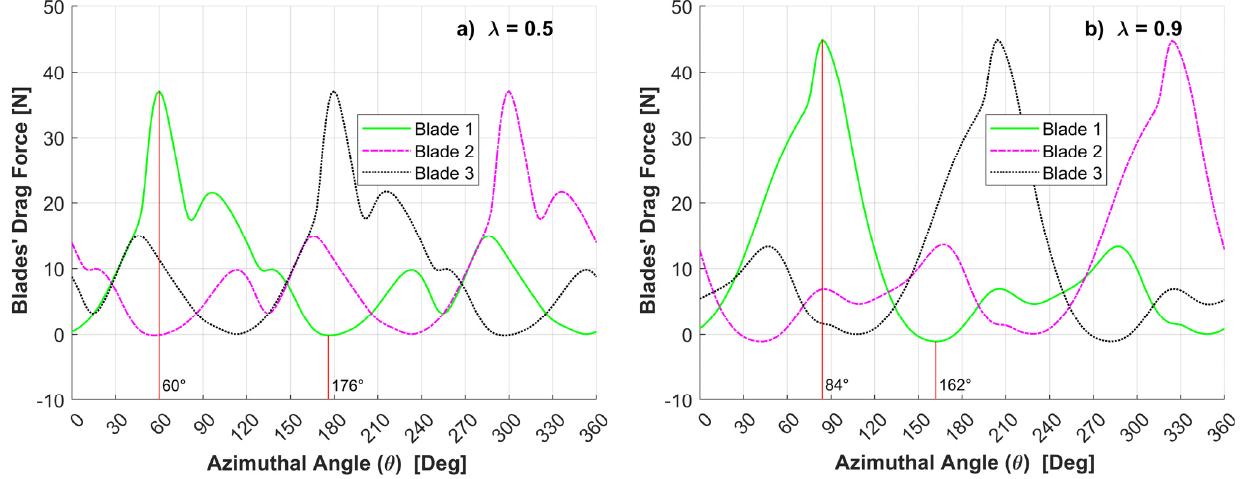
Figure 9. Drag Force for Blades 1, 2 and 3 at Various Azimuthal Angles, for U ∞ = 8 m/s at ( a ) λ = 0.5 and ( b ) λ = 0.9, Using the 2D Model of the Present